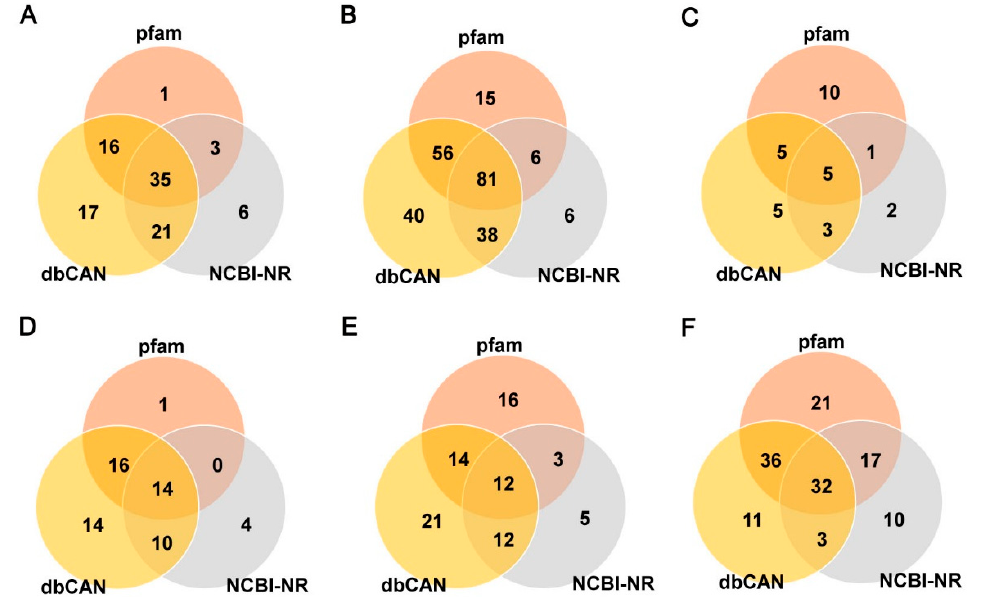
Figure 5. Venn diagrams of CAZymes predicted in F. elastica by three different database searches. ( A ) GT families; ( B ) GH families; ( C ) PL families; (d) CBM families; ( E ) CE families; ( F ) AA families. Pfam, protein family database (Pfam 31.0, http://pfam.xfam.org); dbCAN, CAZyme database (http://csbl.bmb.uga.edu/dbCAN/); NCBI-NR, National Center for Biotechnology Information (NCBI) non-redundant database.